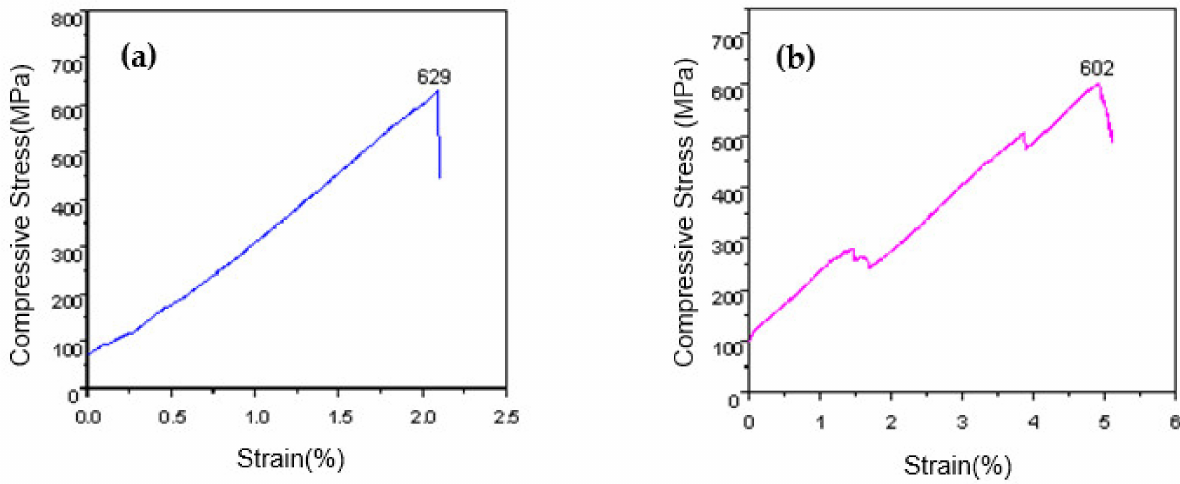
Figure 8. Compressive stress-strain curves of MoNbTaWTi Arc Surfacing layer at the high temperatures: ( a ) T = 500 ◦ C and ( b ) T = 1000 ◦